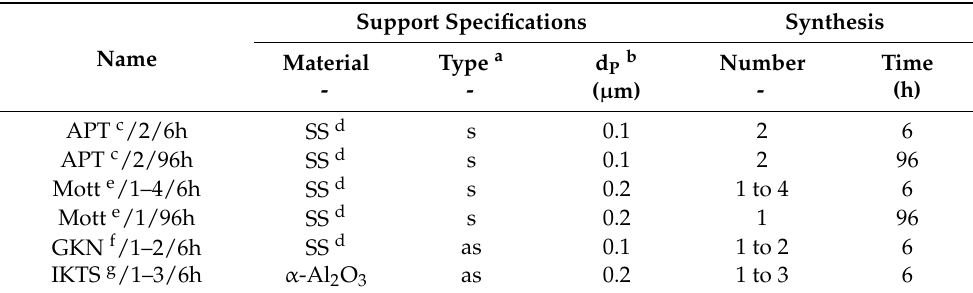
Table 2. Overview on the different supports, their specifications and details on ZIF-11 deposition by in situ crystallization in DEF at 60 ◦